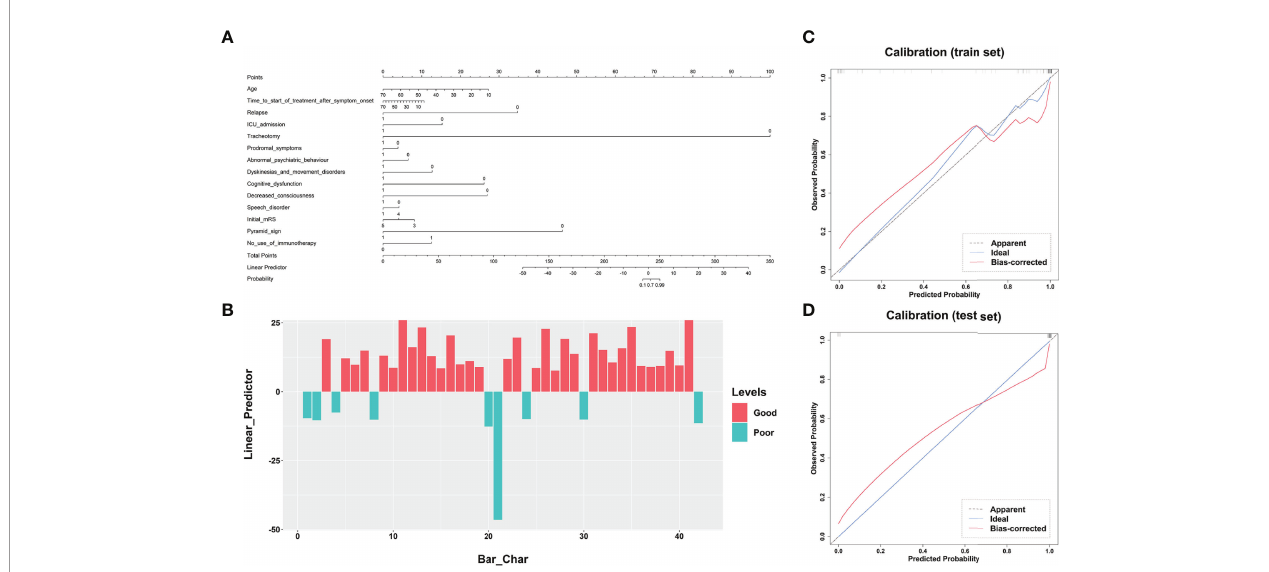
FIGURE 3 | Performance of the clinical model ’ s nomogram. (A) The clinical variable-based nomogram revealed the signi fi cant factors for predicting poor outcomes of anti-NMDAR encephalitis. (B) The fi nal total points are calculated by summing the score of each point represented for each variable. The prediction score of each patient is shown in the test dataset. Calibration curves of the clinical model are displayed in the training set (C) and validation set (D) . The predicted probabilities are shown on the x axis and the actual observed probability is represented on the y axis. The closer the two are to the dotted line, the better the prediction outcome. anti-NMDAR, anti-N-methyl-D-aspartate receptor.